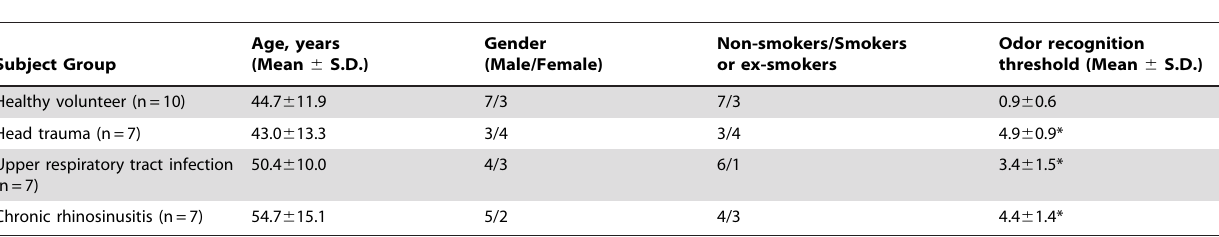
Table 1. Odor recognition thresholds measured by using T&T